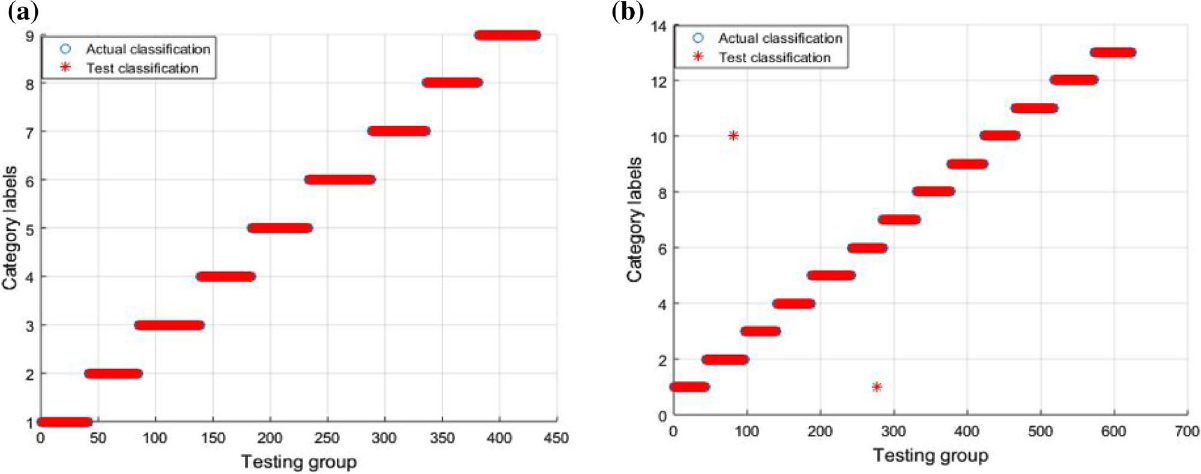
Figure 8. Fault classification result in GWO-SVM: ( a ) classification result for Case 1; ( b ) classification result for Case 2.